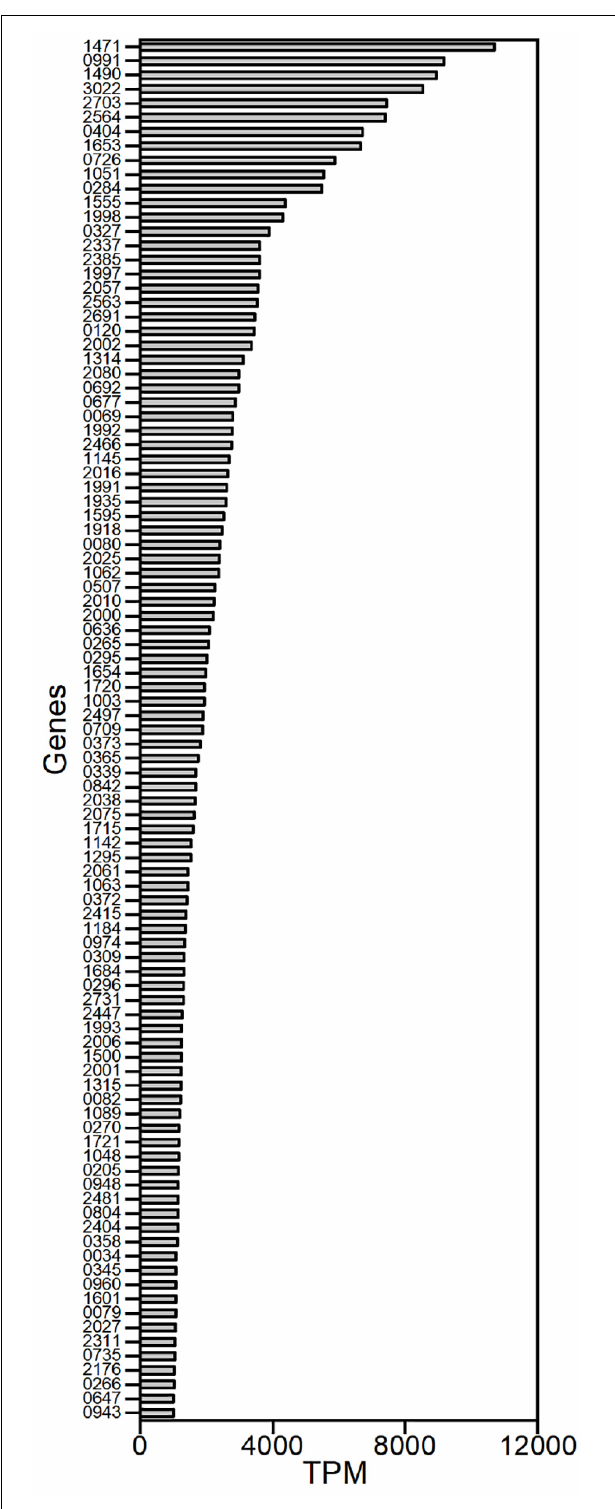
FIGURE 1 | The strongly transcribed genes of G. oxydans WSH-003 obtained by RNA sequencing. The promoters were selected based on transcript per million (TPM) values of the transcriptome. The abscissa axis shows the TPM values. The ordinate axis shows the different genes in G. oxydans